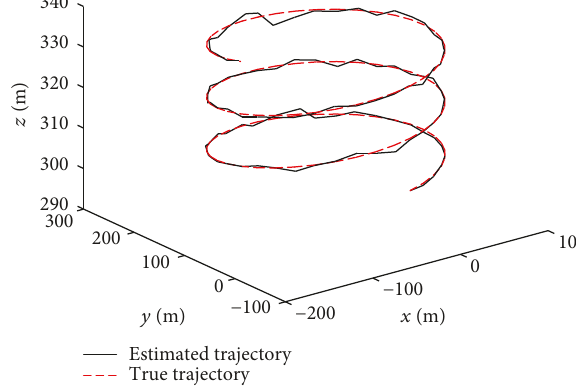
Figure 6: True and estimated trajectories of the target in general formation.